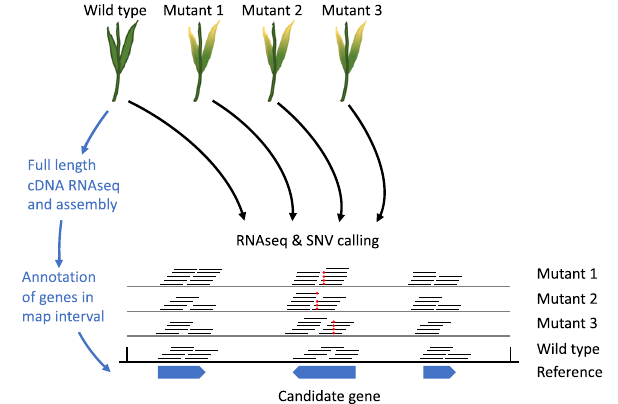
Fig. 2 Candidate gene identi fi cation by mutagenesis and transcriptome sequencing (MutRNA-Seq). RNA-Seq reads from the wild-type parent and independently derived EMS mutants are mapped to a reference genome sequence. Annotated genes are inspected (within a mapping interval, if available) for a gene exhibiting a preponderance of single-nucleotide variants (SNVs, red dots) across the